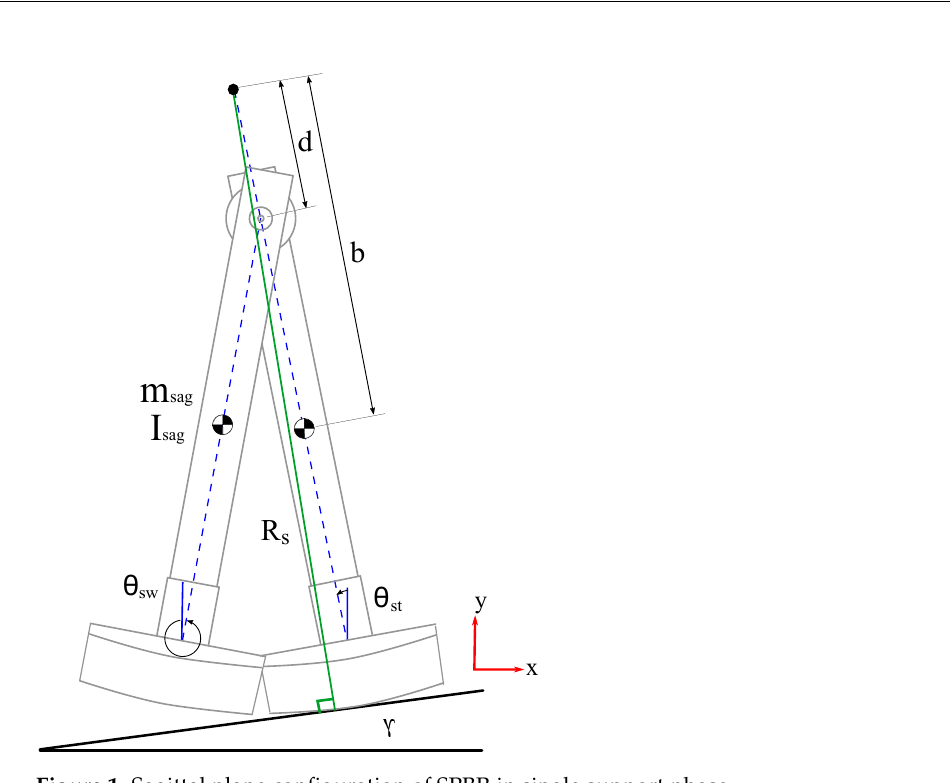
Figure 1. Sagittal plane configuration of SPBR in single support